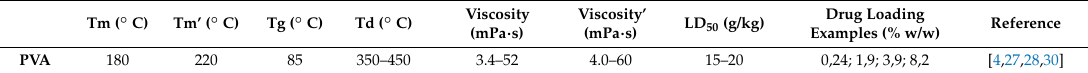
Table 3. Polyvinyl alcohol properties. Key: Tm (melting point for partially hydrolized PVA); Tm’ (melting point for fully hydrolized PVA); Tg (glass transition temperature); Td (degradation